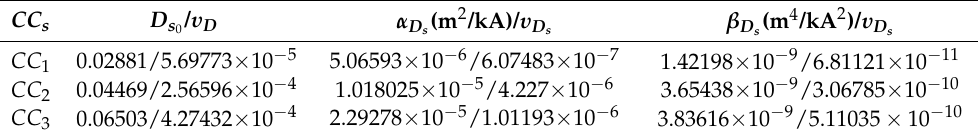
Table 3. The values of R s fitting of data from Figure